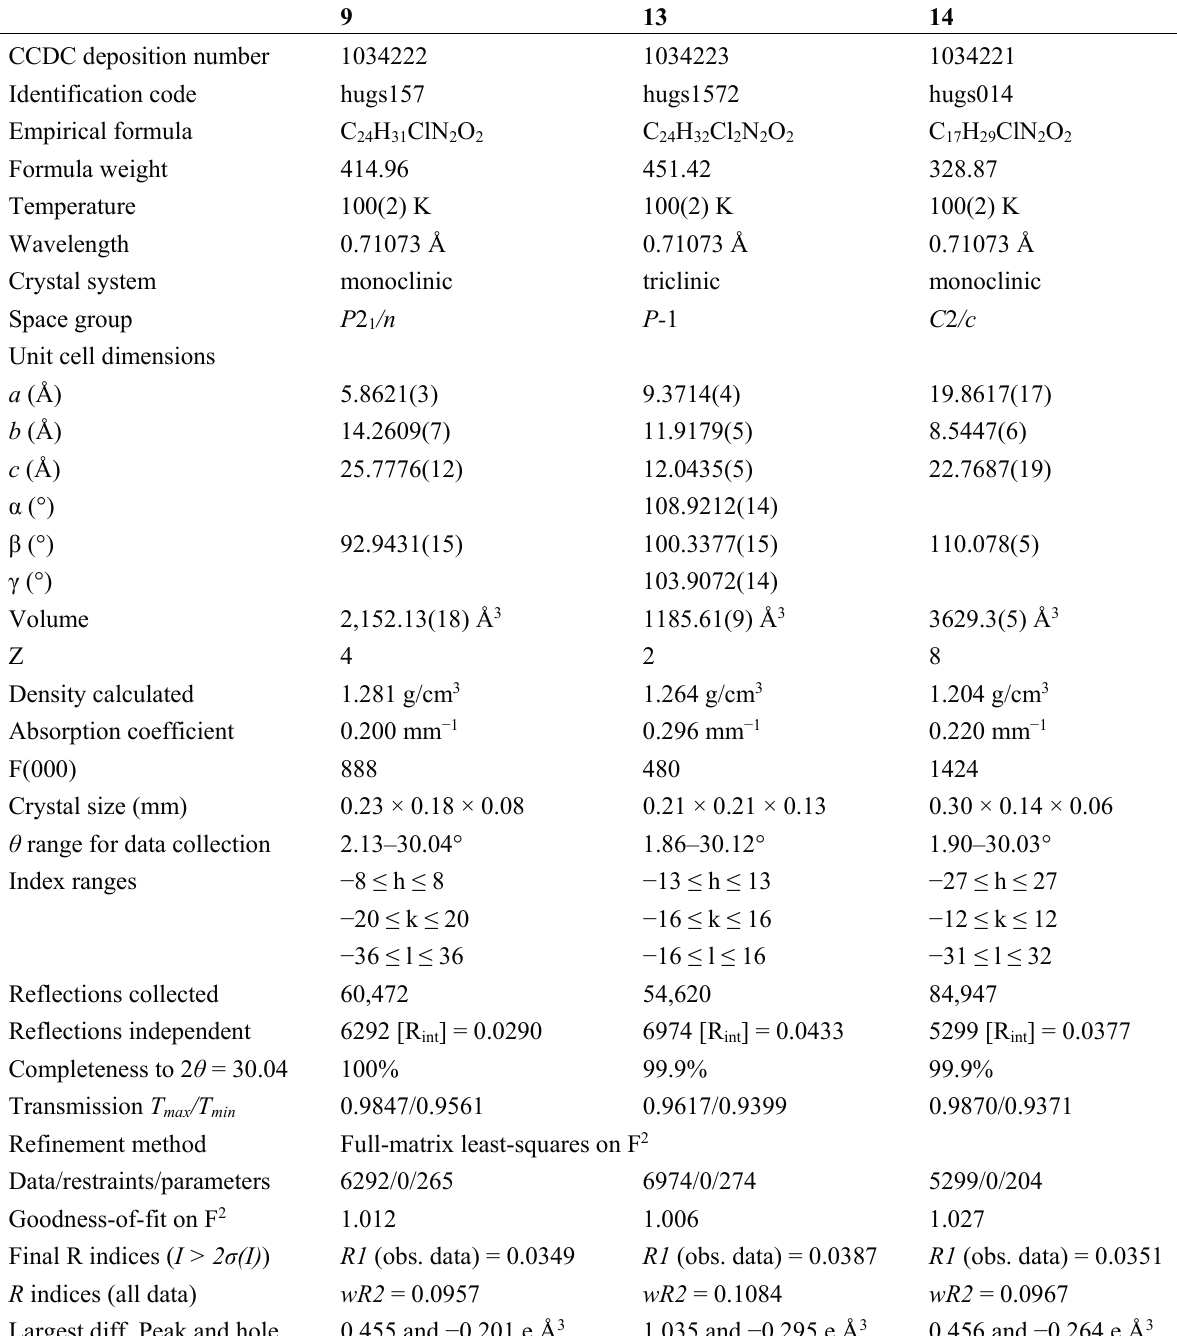
Table 8. Crystallographic data and refinement of compounds 9 , 13 , and 14 . (CCDC, Cambridge Crystallographic Data